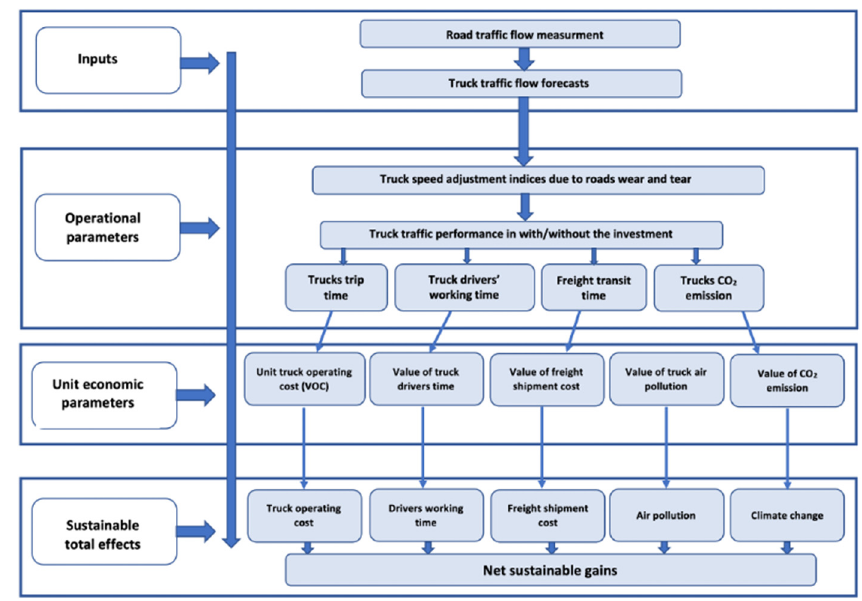
Figure 5. Research framework. Source: own study.